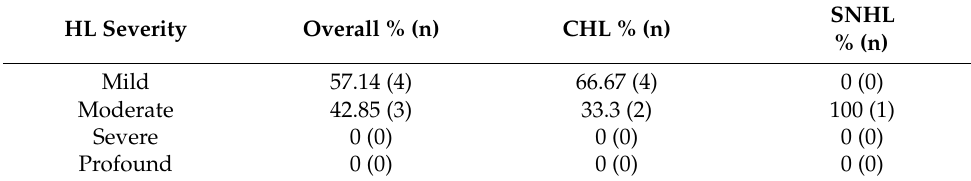
Table 5. Severity of hearing loss of COVID-19